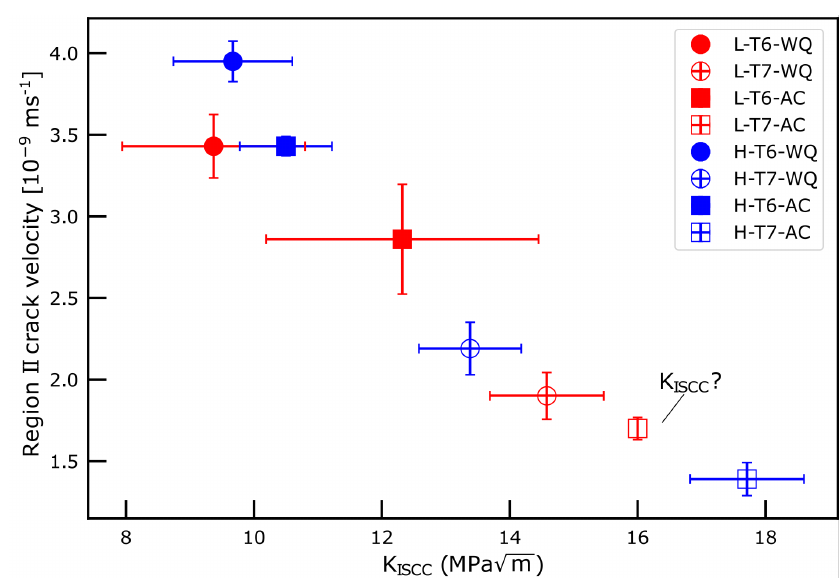
Figure 10. Results from the DCB tests. Average region II crack velocity and K ISCC values from three parallels with corresponding standard deviation. The K ISCC value of the L-T7-AC temper is uncertain as it did not demonstrate a clear drop in crack velocity at low K I values, which all other conditions did. There is a clear trend that the K ISCC values are higher for the T7